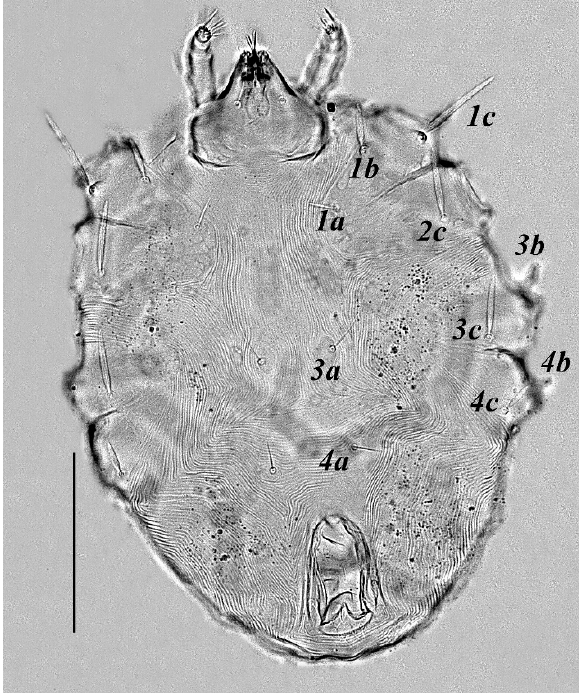
Figure 20. Neophyllobius muscantribii . Female. Venter. Scale bar: 100 μ m.